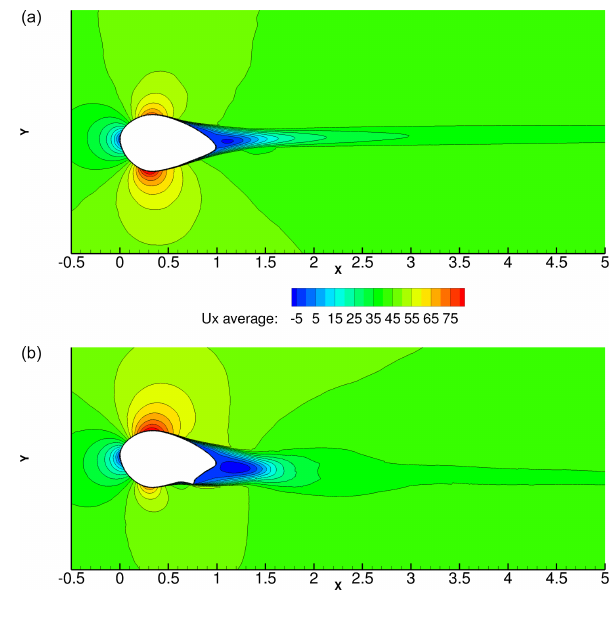
Figure 3. Average horizontal wind speed contour plot for α = 6 ◦